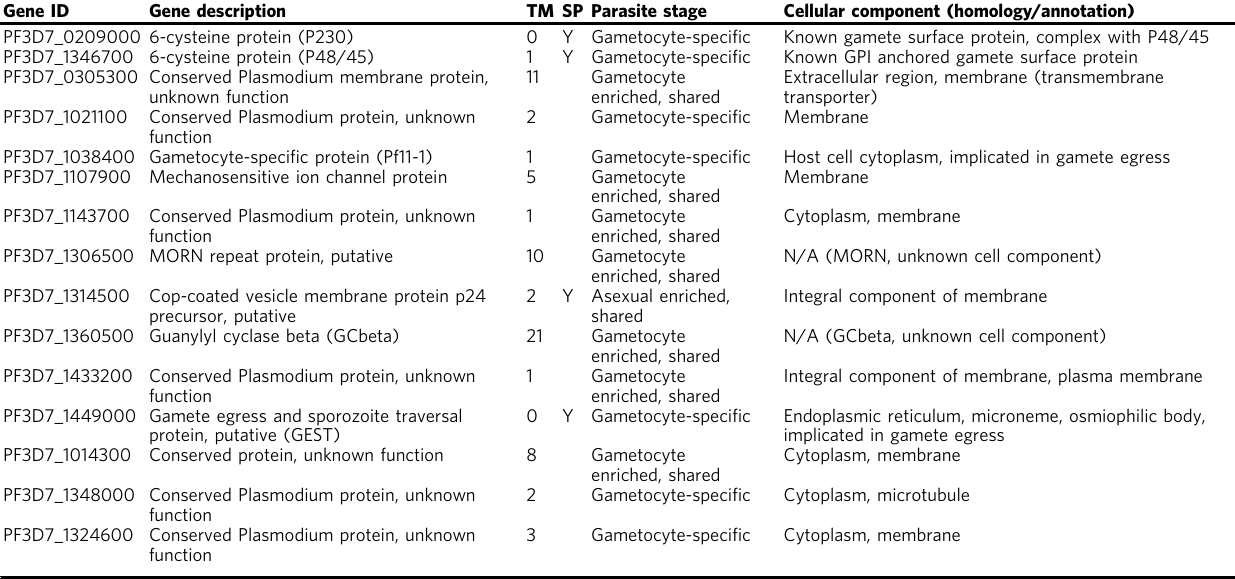
Table 3 Proteins with TRA-associated antibody responses Biomarkers of TR immunity, and plausible or known gametocyte/gamete surface proteins (remaining biomarkers in Supplementary Data 5) Gene